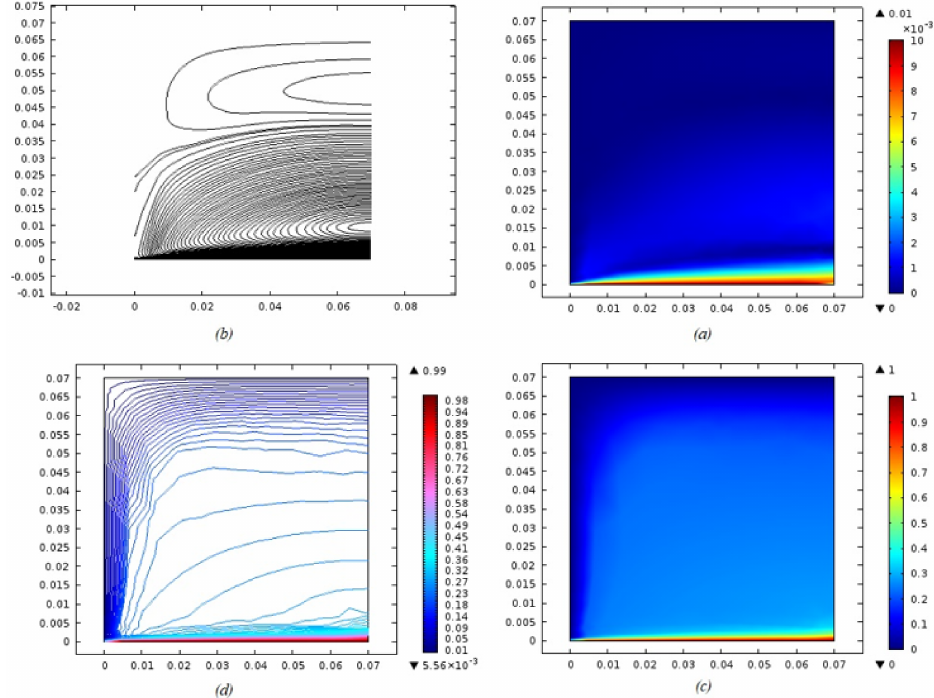
Figure 14. ( a ) Surface plot for velocity; ( b ) streamlines; ( c ) surface plot for temperature; ( d ) isothermal contours using M = 0.5, k p = 1, U w =